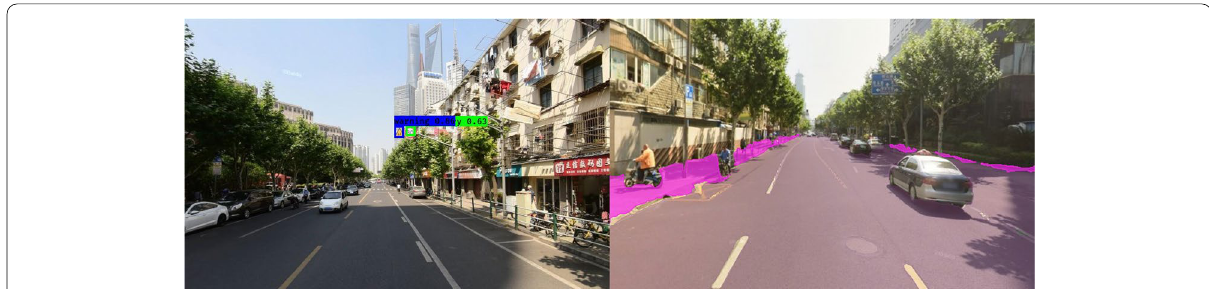
Fig 3 Shop sign and pedestrian area identification from Baidu Street